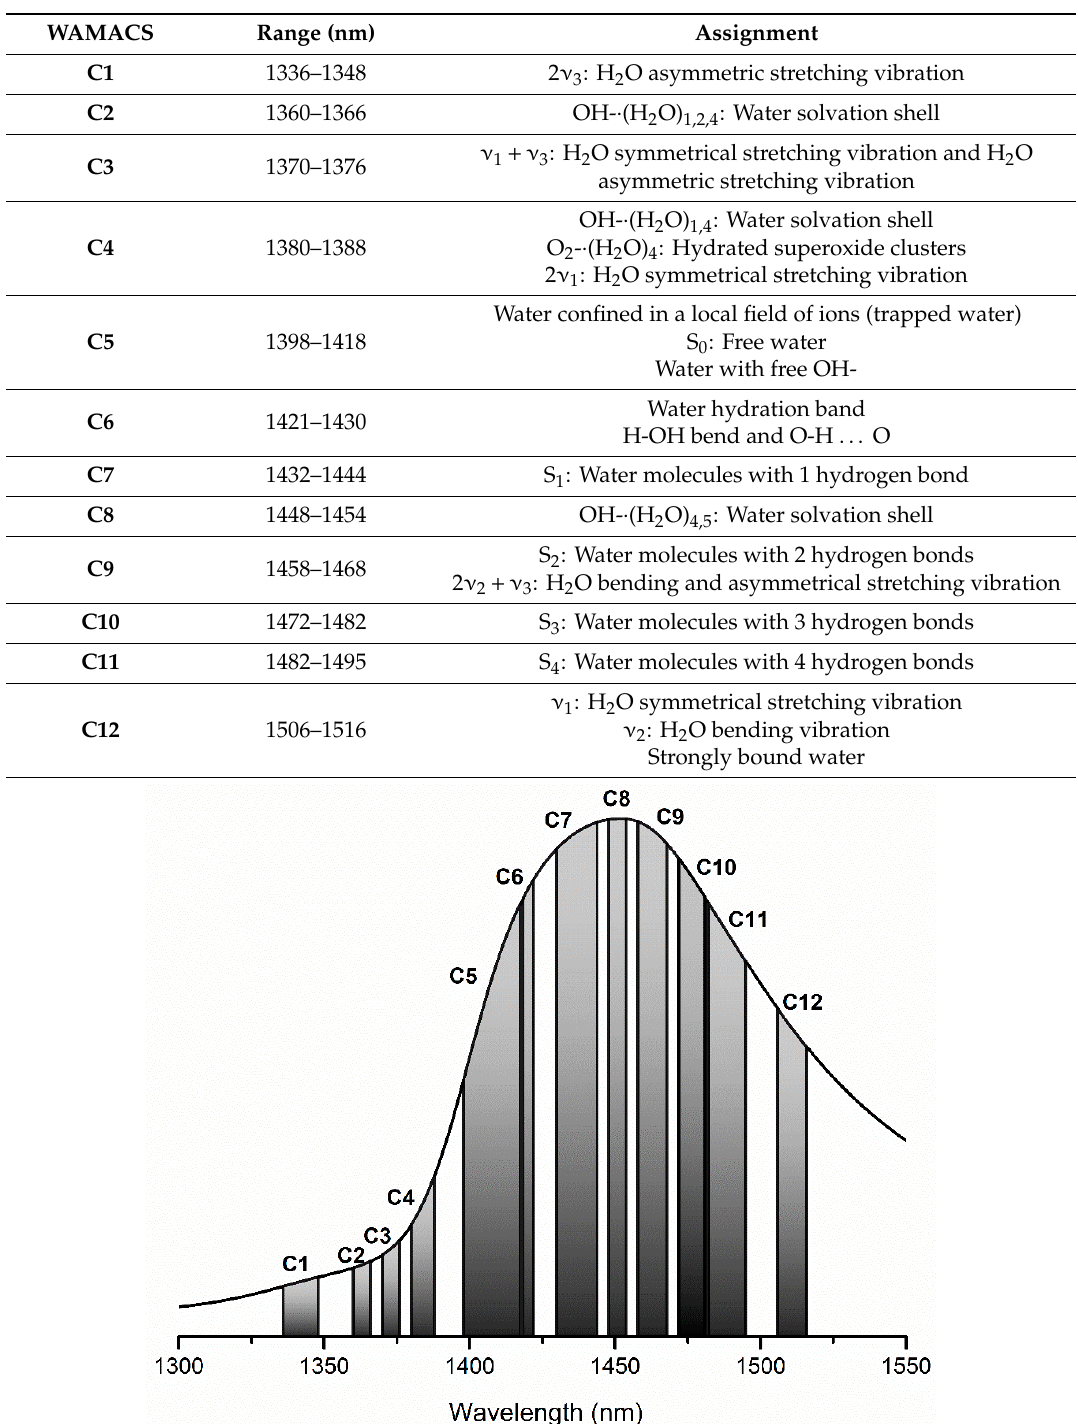
Table 1. Water matrix coordinates in the area of the first overtone of water in the near infrared region (1300 to 1600 nm) (based on